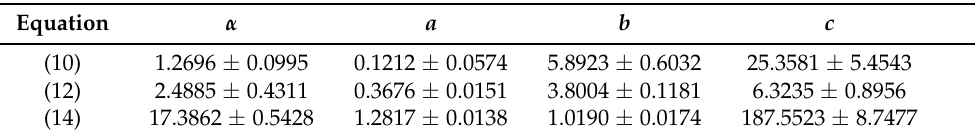
Table 4. Table of experimental parameters with confidence intervals for phenomenological equations of polypropylene, polyester, and